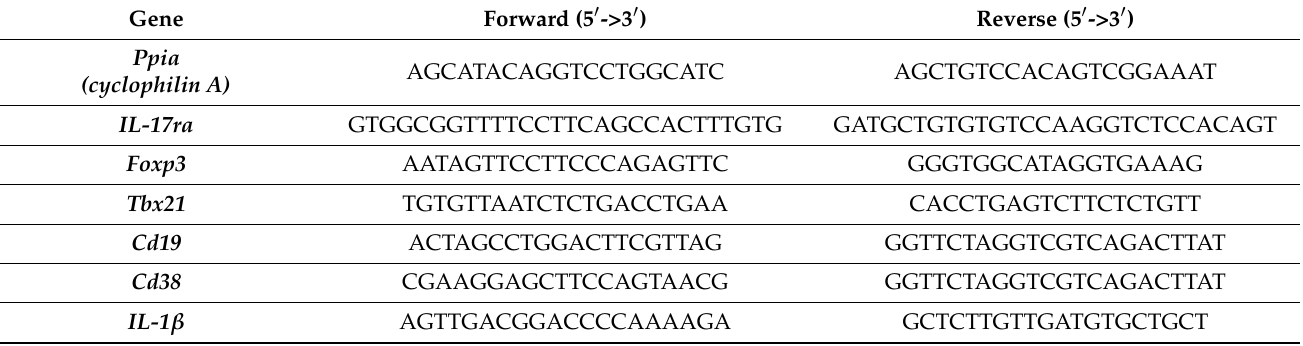
Table 1. List of primer